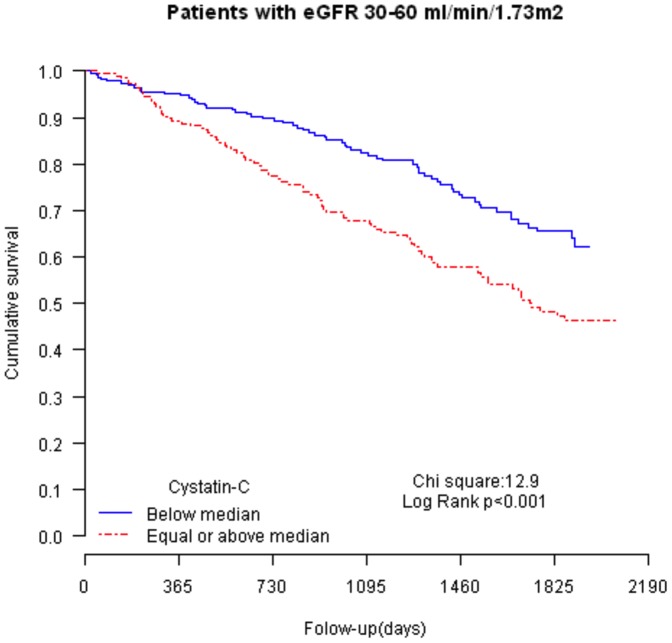
Kaplan–Meier survival curves according to cystatin-C levels in patients with an eGFR between 30 and 60 ml/min/1.73 m2.Caption: cystatin-C levels have been divided according to median values (below vs. equal/above). N = 443.